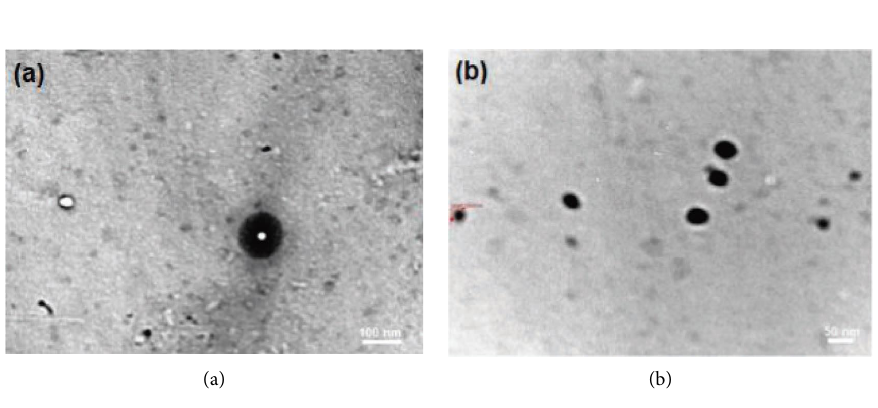
Figure 3: TEM photograph of (a) B-PLGA-NPs and (b) FU-PLGA-NPs.